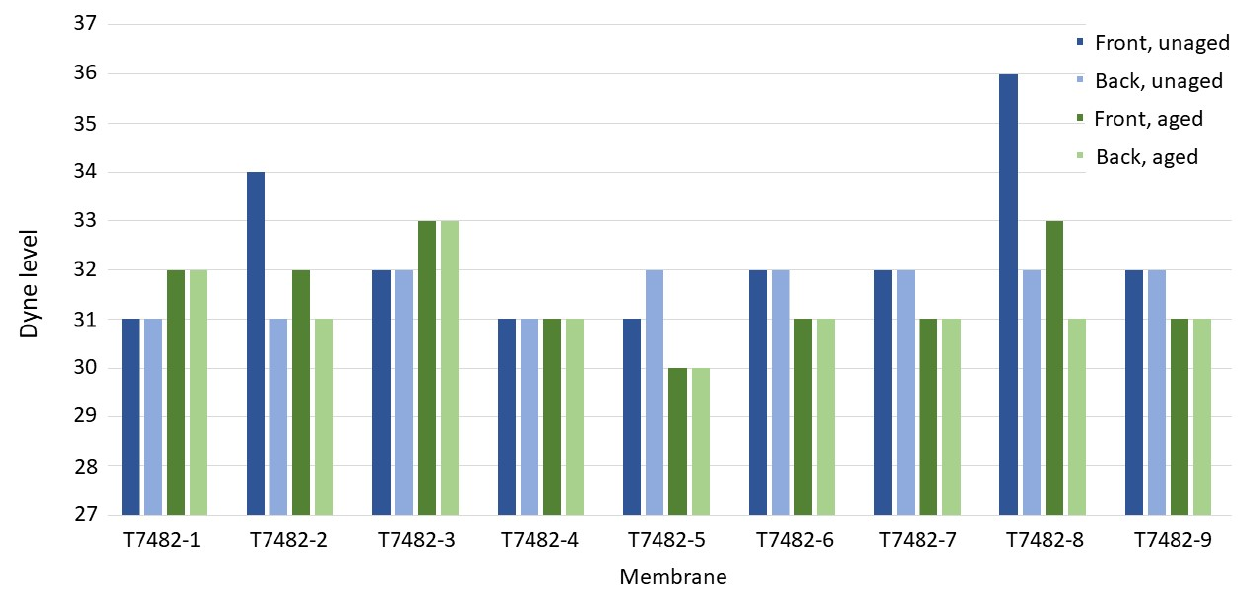
Figure 19. Surface tension expressed as the dyne level for the front cover (with print) and backside of the unaged and aged samples examined.